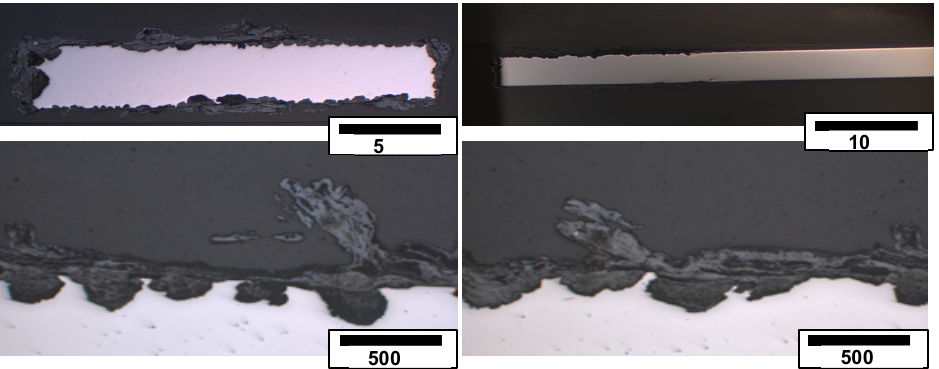
Figure 4. Depicted surface cross-sections with heavy local corrosive attack after 8000 h of exposure at 60 °C and 1 bar of X35CrMo17.